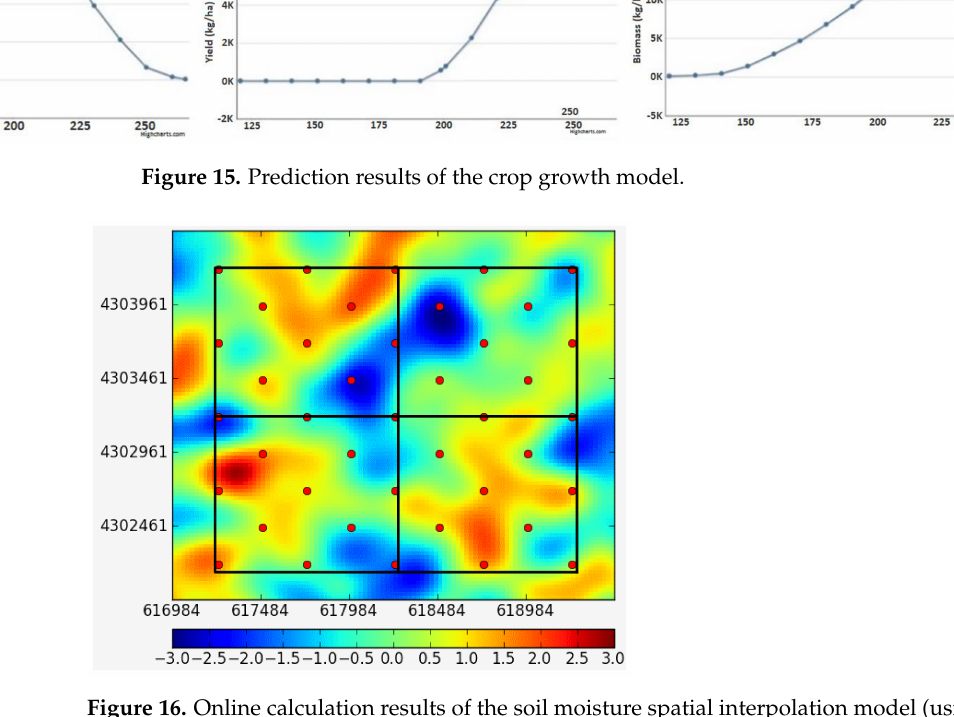
Figure 16. Online calculation results of the soil moisture spatial interpolation model (using discrete soil moisture observational data as the input, the platform calls the online spatial interpolation model to calculate the spatial distribution data for soil